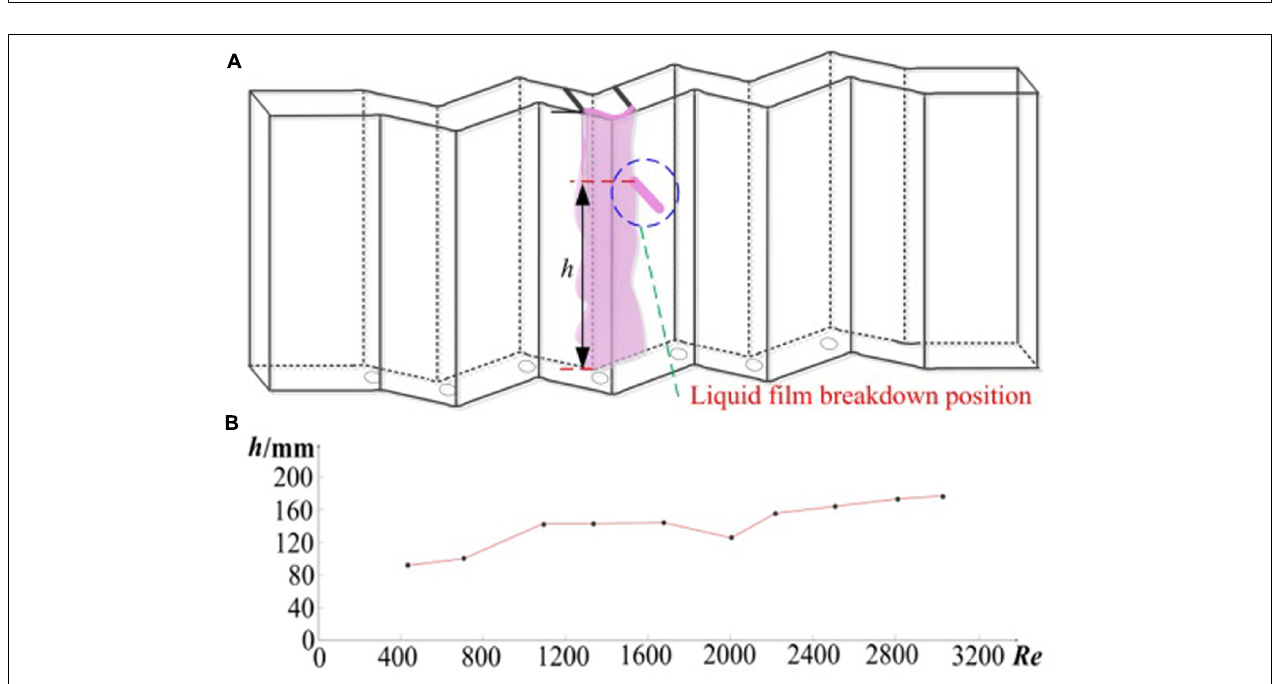
FIGURE 3 | Liquid film rupture (LFR) position. (A) Schematic diagram of the LFR position. (B) Curve of the LFR position for different Re.